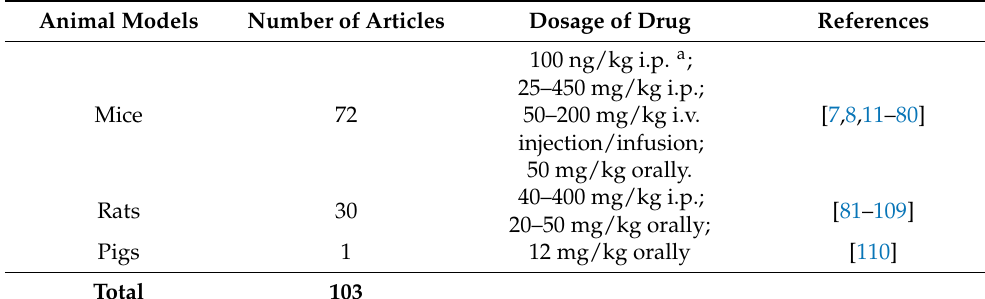
Table 1. Summary of data collected from in vivo animal studies involving 5-fluorouracil-induced intestinal mucositis. Drug concentrations obtained from studies are listed in a range of minimum to maximum dosage administered in animal models.